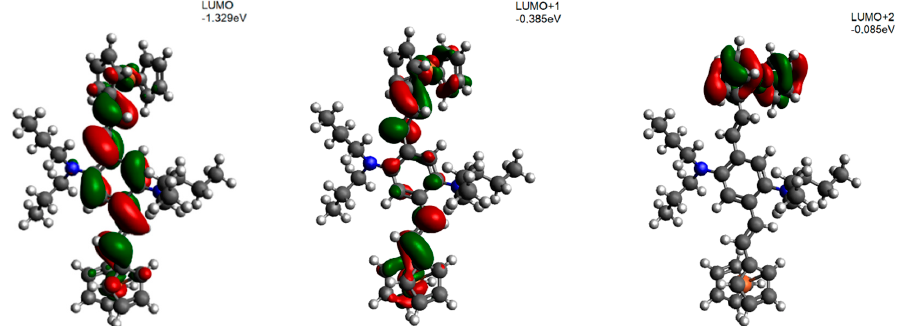
Figure 5. Unoccupied frontier orbitals: LUMO, LUMO+1 and LUMO+2.